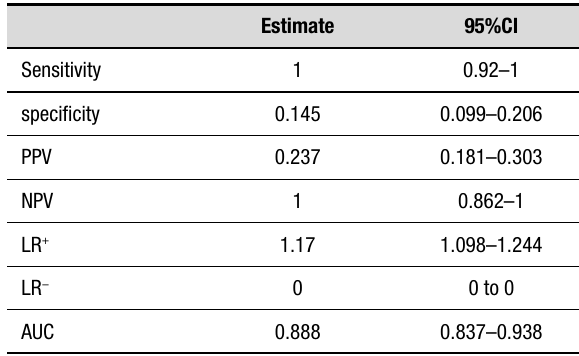
Table 2. Accuracy of the Persian version of the Telephone Interview for Cognitive Status – modified versus MMSE test in identifying cognitive impairment from healthy older adult (n=210).